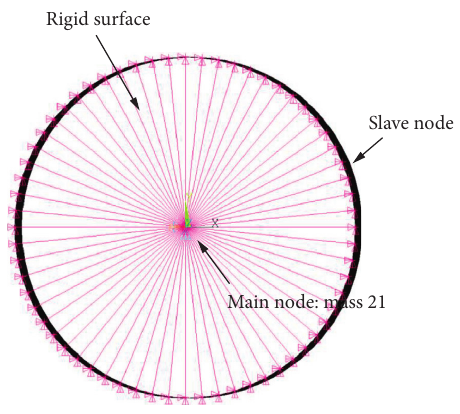
Figure 2: End of specimen setup.